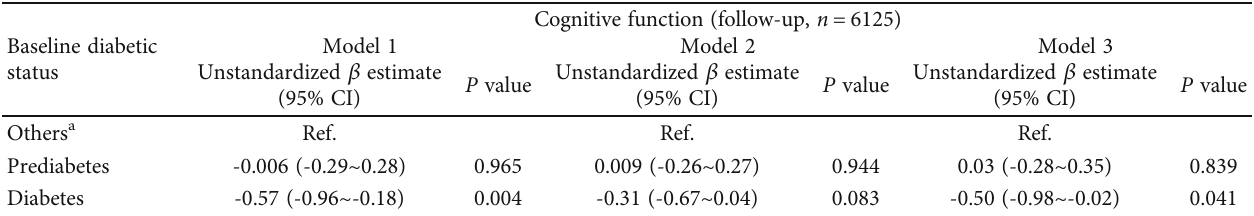
Table 2: Eight-year association between baseline diabetic status and subsequent cognitive function (multivariable analyses). Baseline diabetic